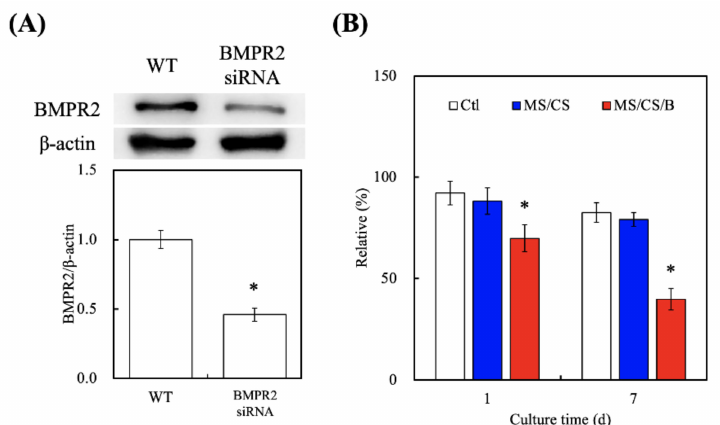
Figure 8. ( A ) Western blotting of knockdown by pairs of BMPR2-specific siRNAs in hDPSCs. ( B ) The effects on siRNA–BMPR2 transfection of proliferation in hDPSCs cultured on scaffolds for 1 and ( B ) 7 days. * indicates a significant difference ( p < 0.05) when compared to